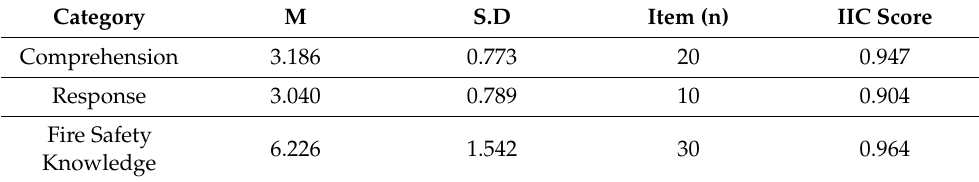
Table 3. Analysis results of the internal consistency of the survey